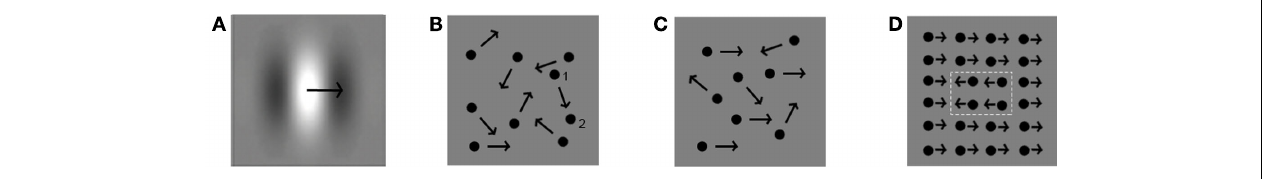
FIGURE 6 | Examples of stimuli used in different motion-processing tasks. (A) Movement of a single Gabor. (B) Random dot kinematogram with 0% motion coherence, and dot displacement distance indicated for one dot